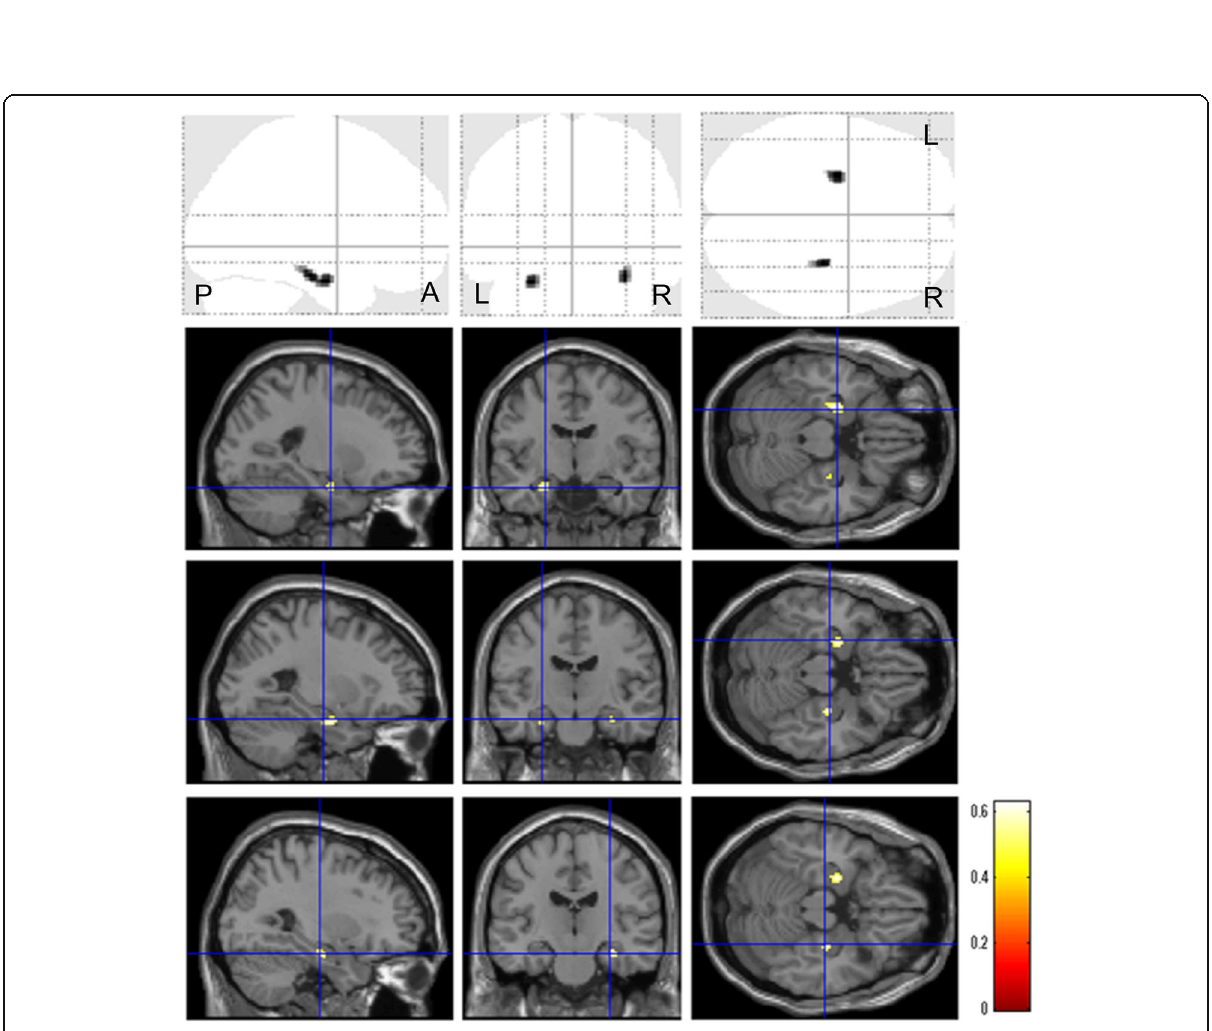
Fig. 2 Voxel-wise correlations between 18 F-THK5351 accumulation and gray matter volume in normal older adults. Significant negative correlations between 18 F-THK5351 accumulation and gray matter volume were detected in the bilateral medial temporal lobes (voxel threshold of p <0.001 with a 30-voxel extent threshold). A anterior, P posterior, R right, L